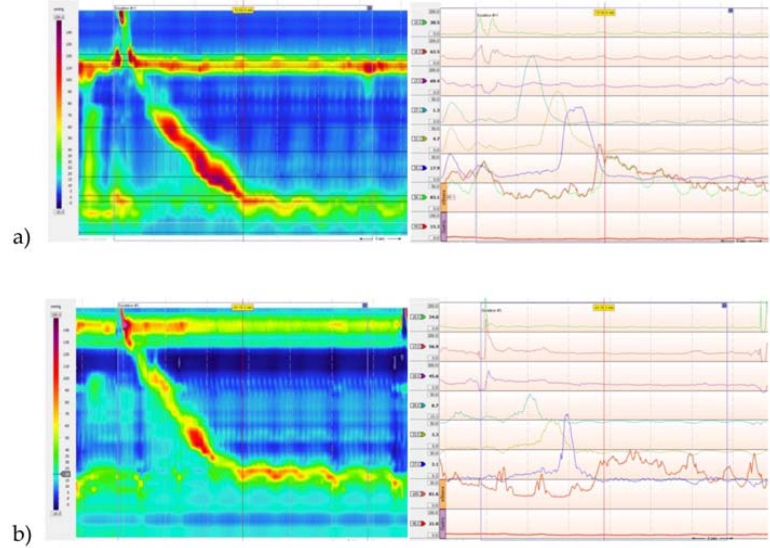
location of the cricopharyngeus impression.